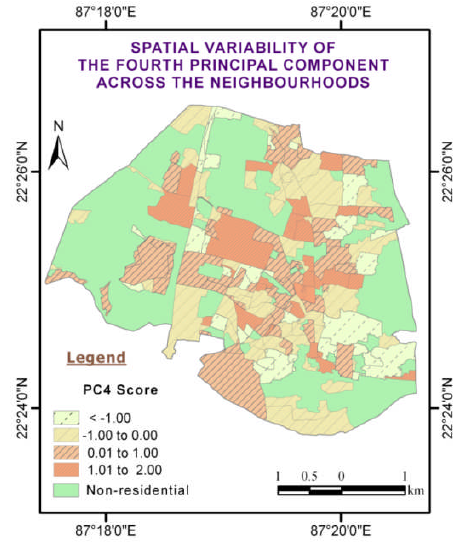
Figure 5. Fourth Principal Component and